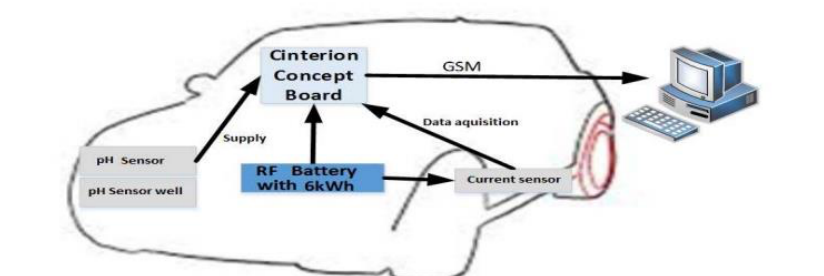
Figure 2 . Integration of the tele-monitoring system for a vehicle equipped with a RF 6kWh battery